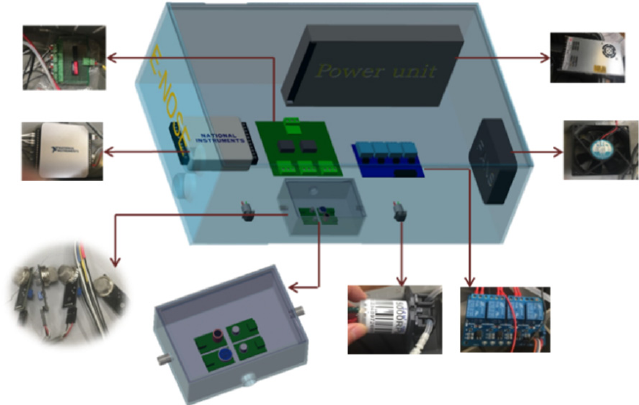
Figure 1. Components of the developed E-nose system. Table 1. Gases detected by each sensor employed in E-nose system.